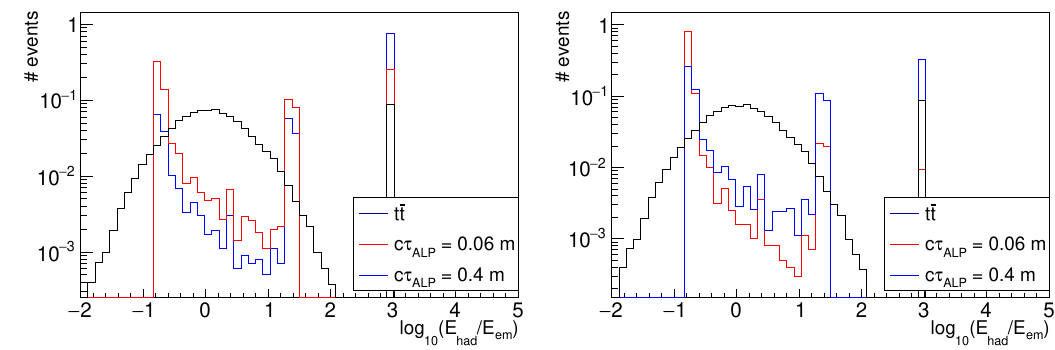
Figure 4 . Calorimeter energy deposit ratio log ( E had /E em ) distribution for the t ¯ t background as 10 well as for the signal with cτ ALP = 0 . 06 , 0 . 4 m and m a = 2 GeV (left) and m a = 10 GeV